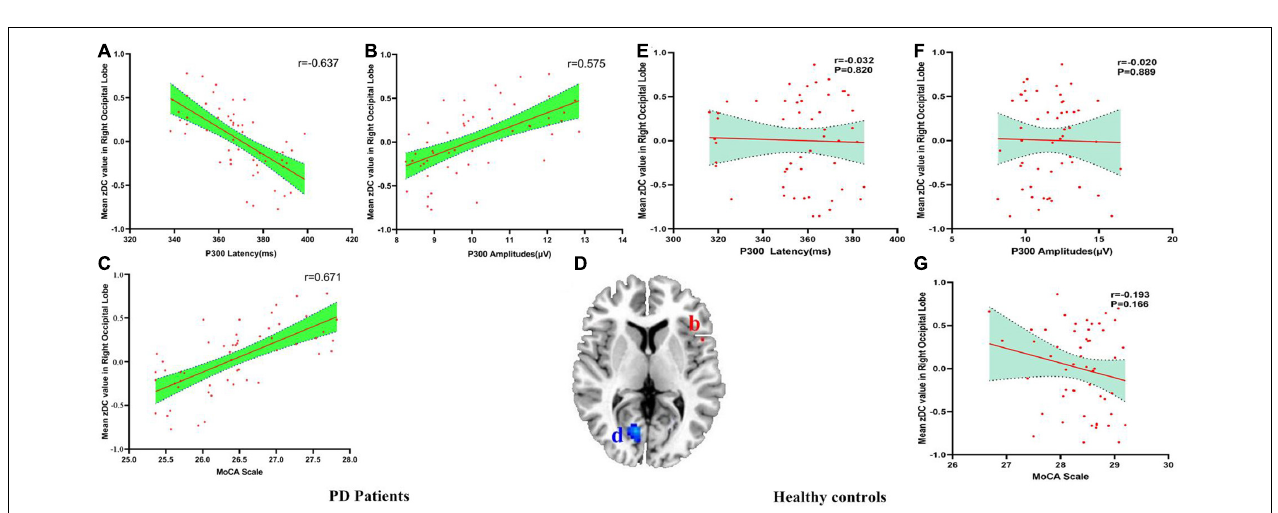
FIGURE 2 | (A–G) The correlation results between mean zDC value in left medial frontal gyrus and P300 latency, P300 amplitudes and MoCA scale in PD patients and healthy controls. DC, Degree Centrality. The brain region in the red Alphabet c was left medial frontal gyrus.